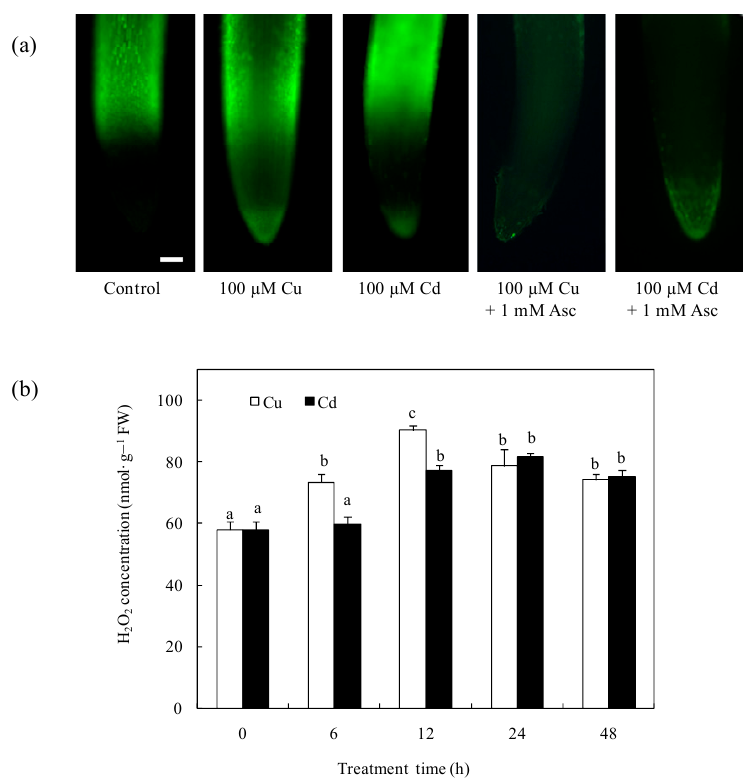
Figure 1. Cu- and Cd-induced H 2 O 2 accumulation in rice radicles. ( a ) Histochemical detection of H 2 O 2 in rice radicles under different treatment for 12 h; ( b ) The total contents of H 2 O 2 in rice radicles under varied Cu or Cd treatment time. Germinating rice embryos were treated with 1 mM ascorbic acid (Asc) solution for 12 h, or treated with 100 μ M CuSO 4 and 100 μ M CdCl 2 solution for 0, 3, 6, 12, 24, and 48 h. Subsequently radicles from germinating rice seeds were incubated in 20 μ M H 2 DCFDA for 20 min or were homogenized and the H 2 O 2 content assayed by spectrophotometry. Bar, 100 μ m. Experiments were repeated at least three times with similar results. Values are means ± SE ( n = 3) of three separate experiments. Means denoted by the same letter did not significantly differ at p < 0.05 according to Duncan’s multiple range test.